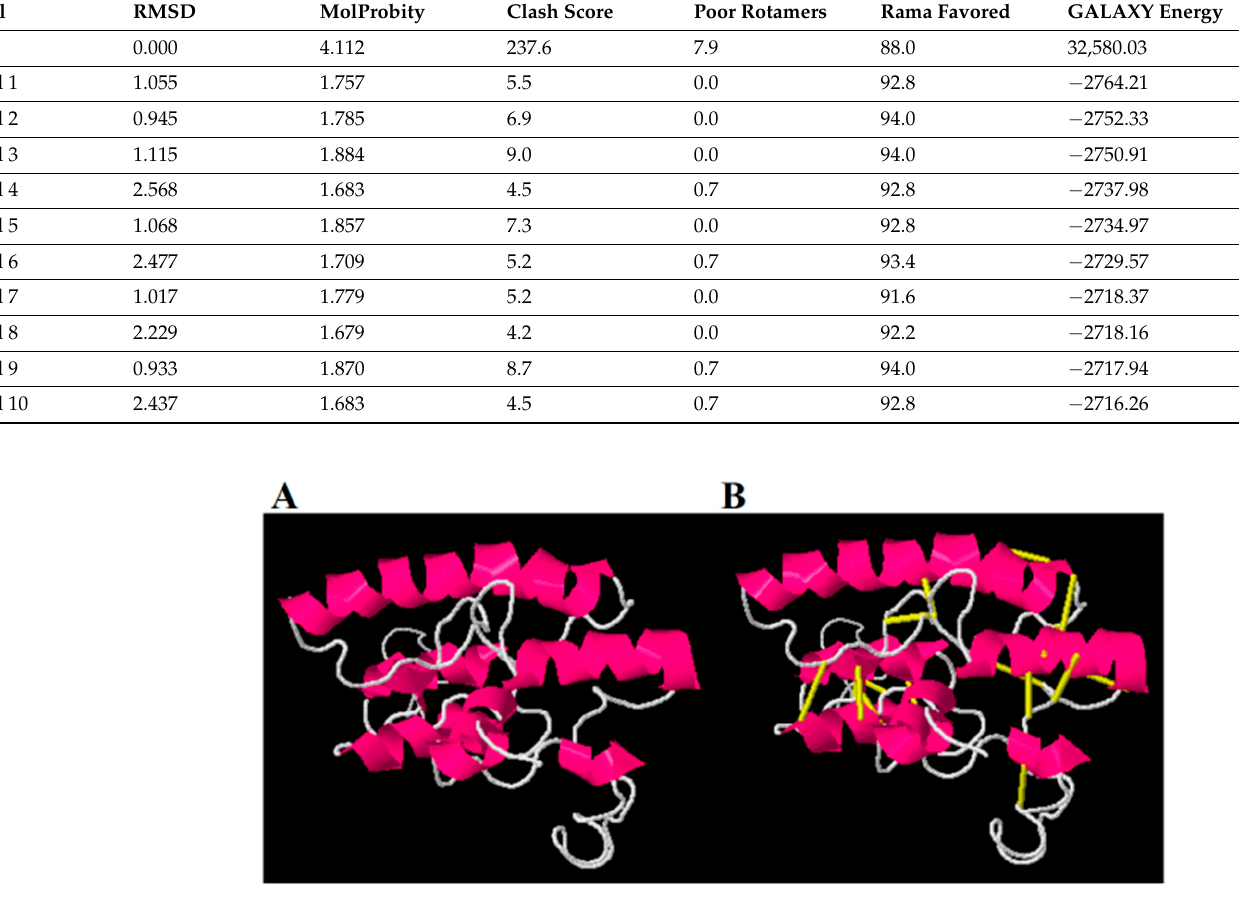
Figure 8. Wild structure of the vaccine ( A ) and mutated structure of the vaccine ( B ). The yellow sticks represent replaced amino acids.